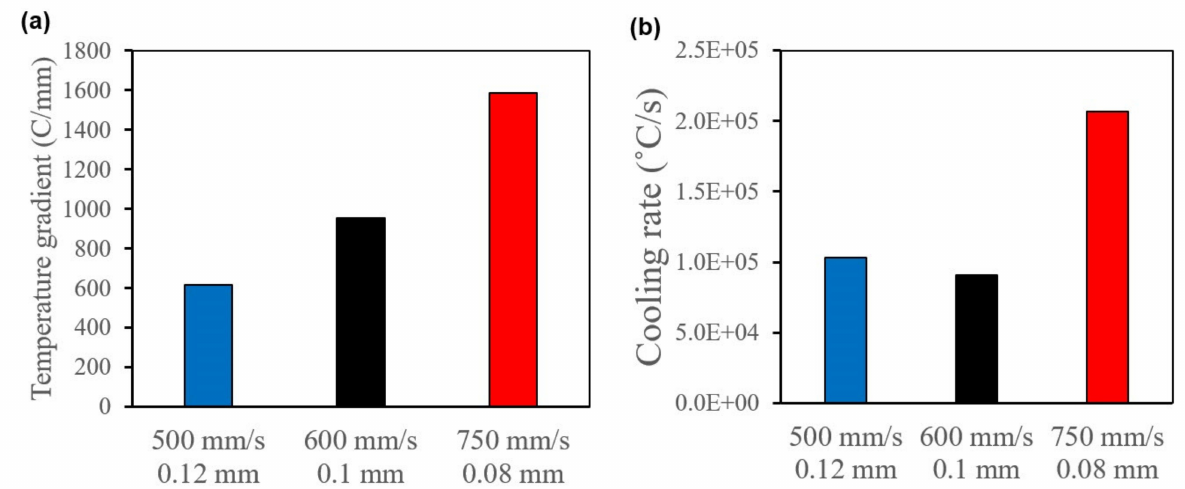
Figure 35. Effect of the same energy density of 3.67 J/mm 2 on ( a ) temperature gradient and ( b ) CR.